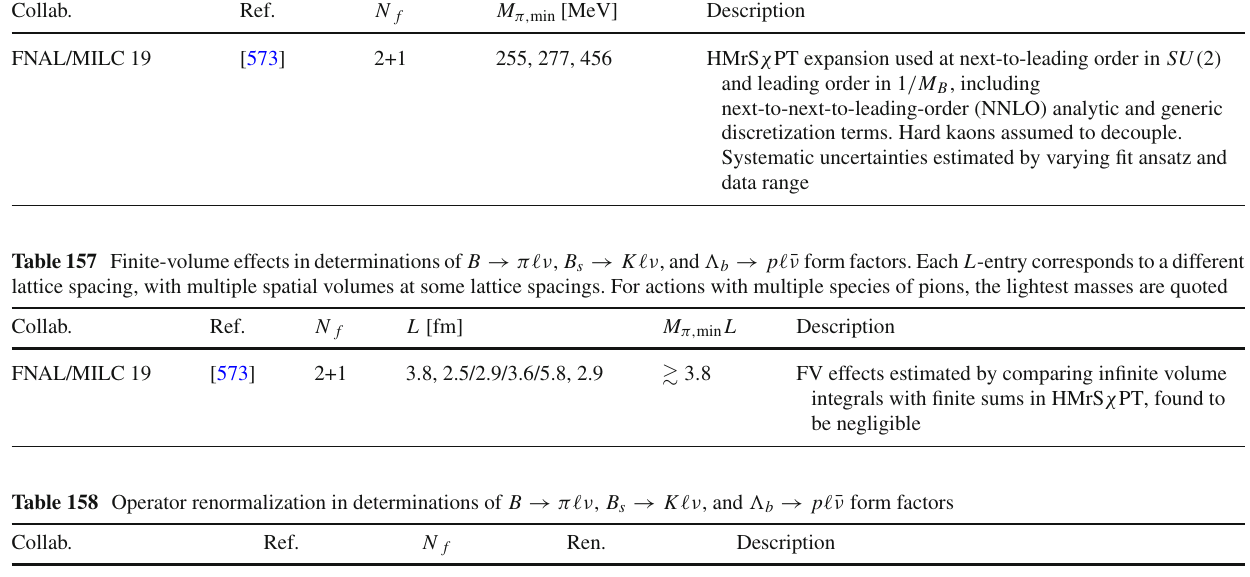
Table 156 Chiral extrapolation/minimum pion mass in determinations of B → π(cid:6)ν , B s → K (cid:6)ν , and (cid:8) b → p (cid:6) ¯ ν form factors. For actions with multiple species of pions, masses quoted are the RMS pion masses. The different M π, min entries correspond to the different lattice spacings Collab.